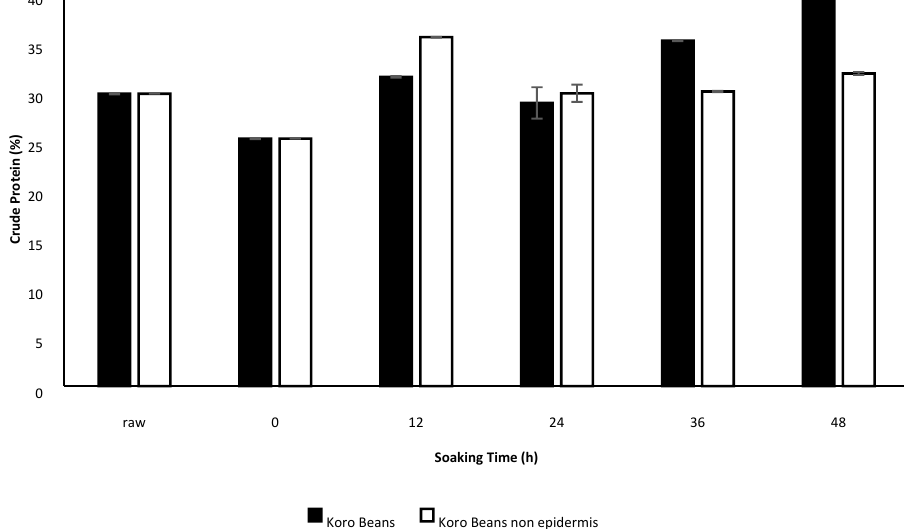
Figure 1. Crude protein content in soaked dehulled Jack beans.